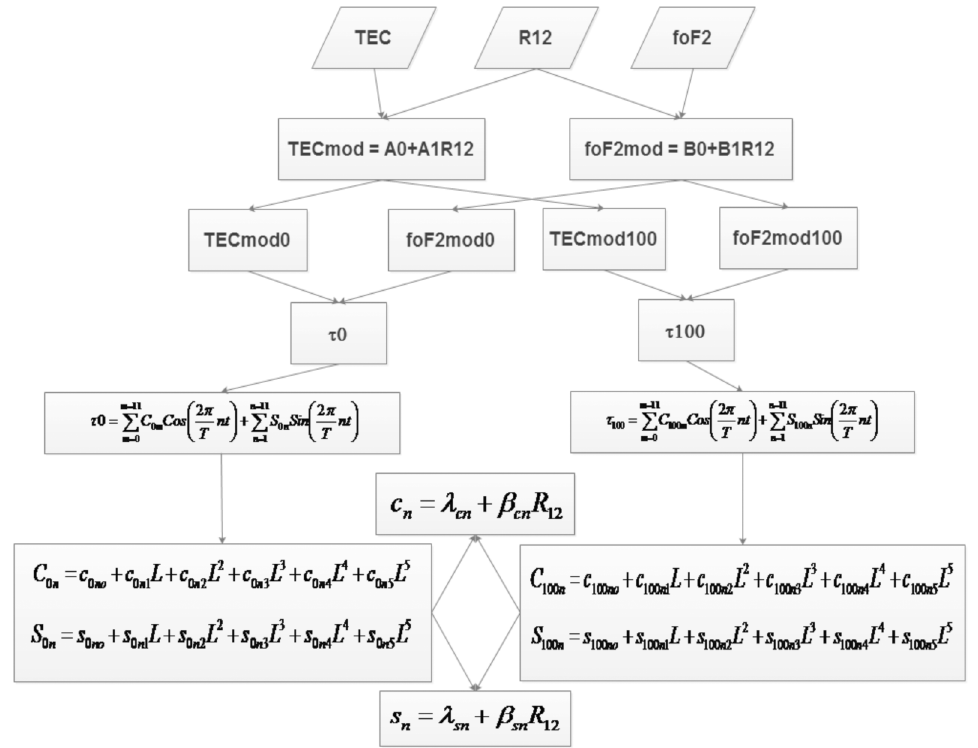
Figure 1. GMIST modeling procedures.